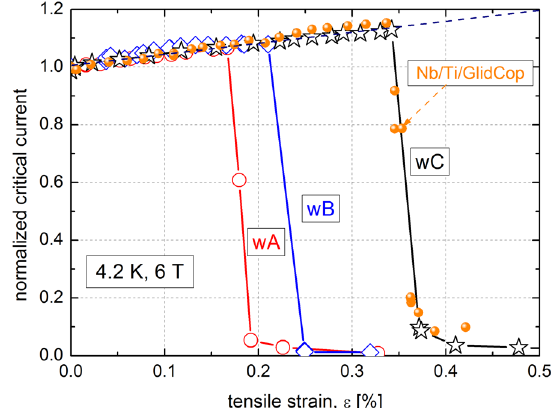
Figure 4. Strain tolerances of the wA, wB and wC wires to tensile stress at 4.2 K compared with a similar wire with a GlidCop outer